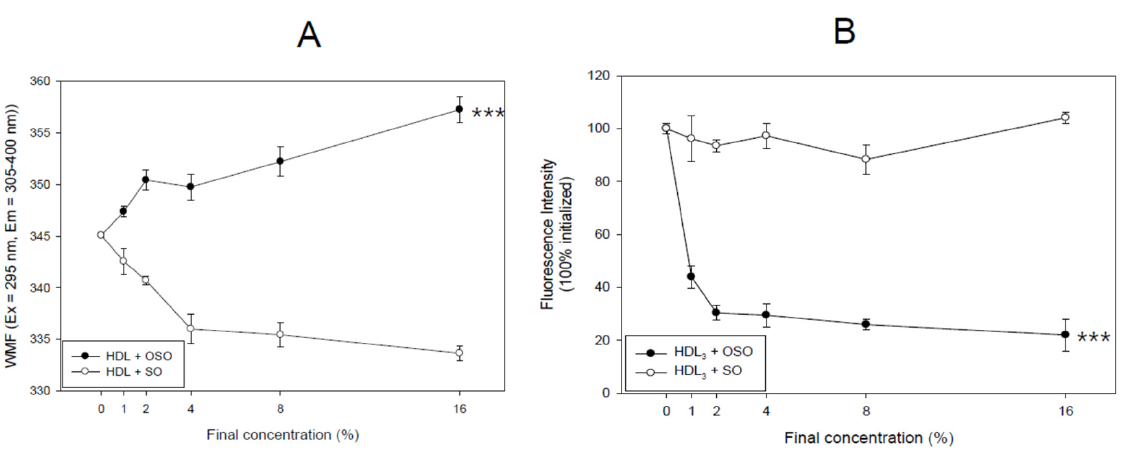
Figure 2. Measurement of the Trp fluorescence in HDL 3 . ( A ) Change in the wavelength-maximum fluorescence (WMF) depends on the ozonated sunflower oil (OSO) treatment. *** p < 0.005 between OSO and SO; ( B ) change in the fluorescence intensity (FI) dependent on OSO treatment. *** p < 0.005 between OSO and SO.